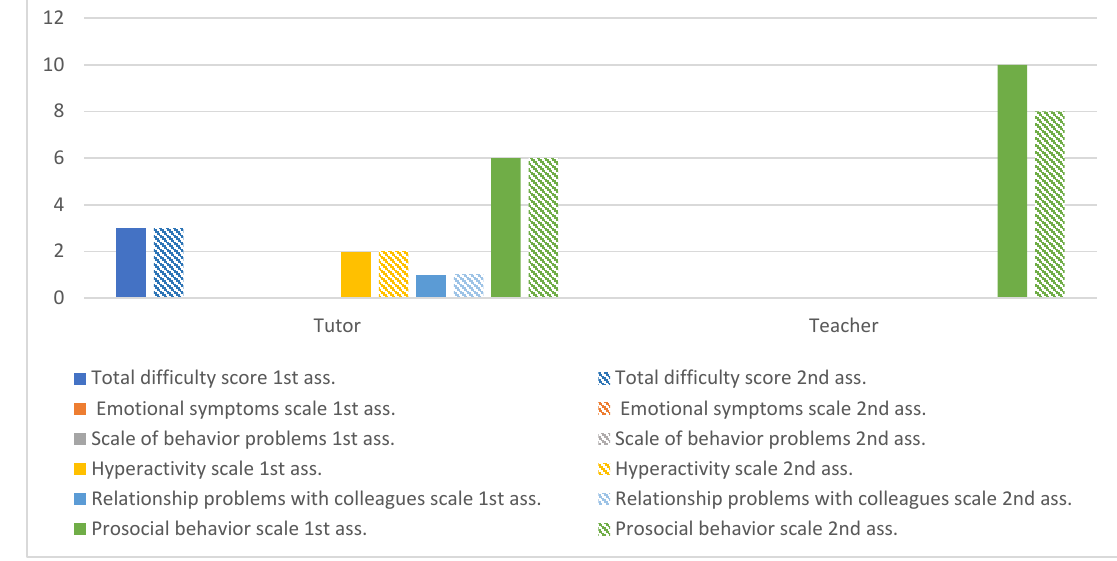
Figure 7. Nuno ’ s global assessment of SDQ. Figure 7. Nuno’s global assessment of SDQ.